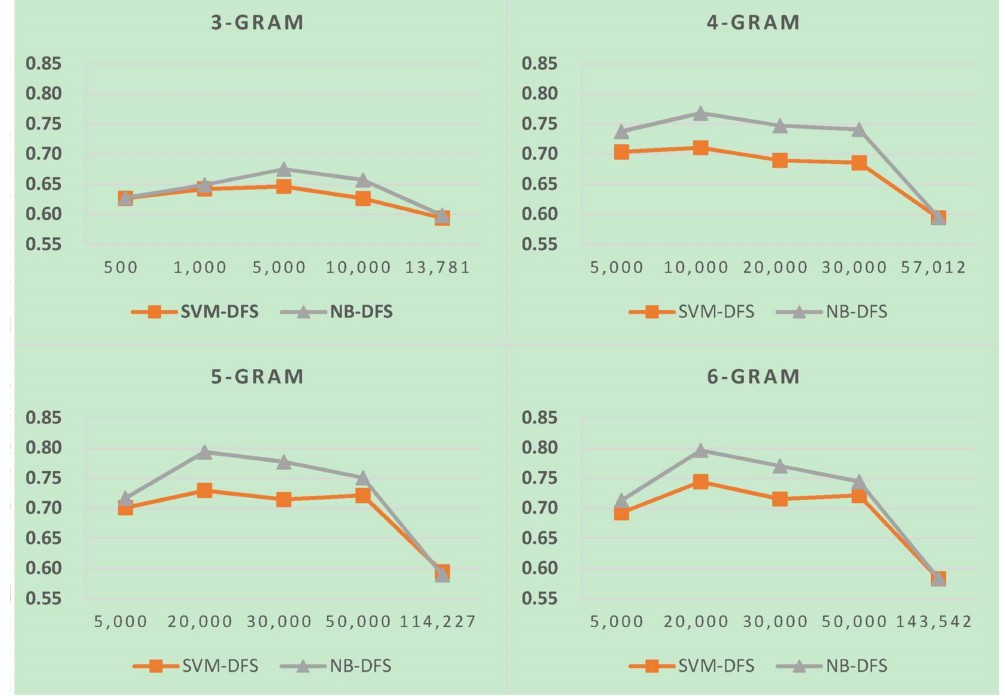
Figure 13. LI in SLG consisting of ind and